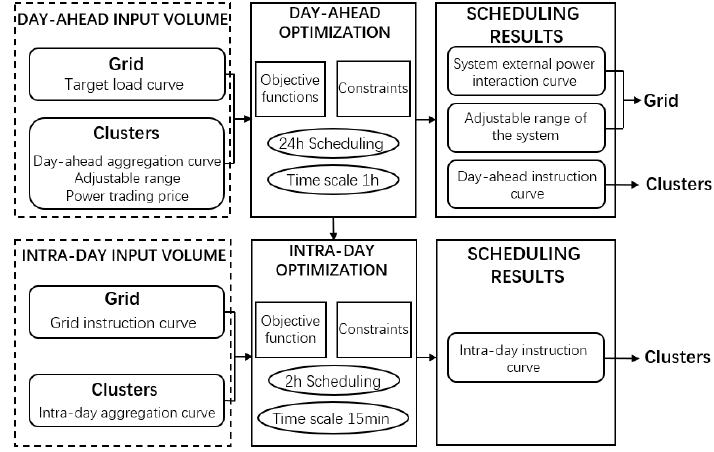
Figure 3. Flow chart of multi-timescale optimization method of clusters. The specific processes of the day-ahead optimization phase are as follows.